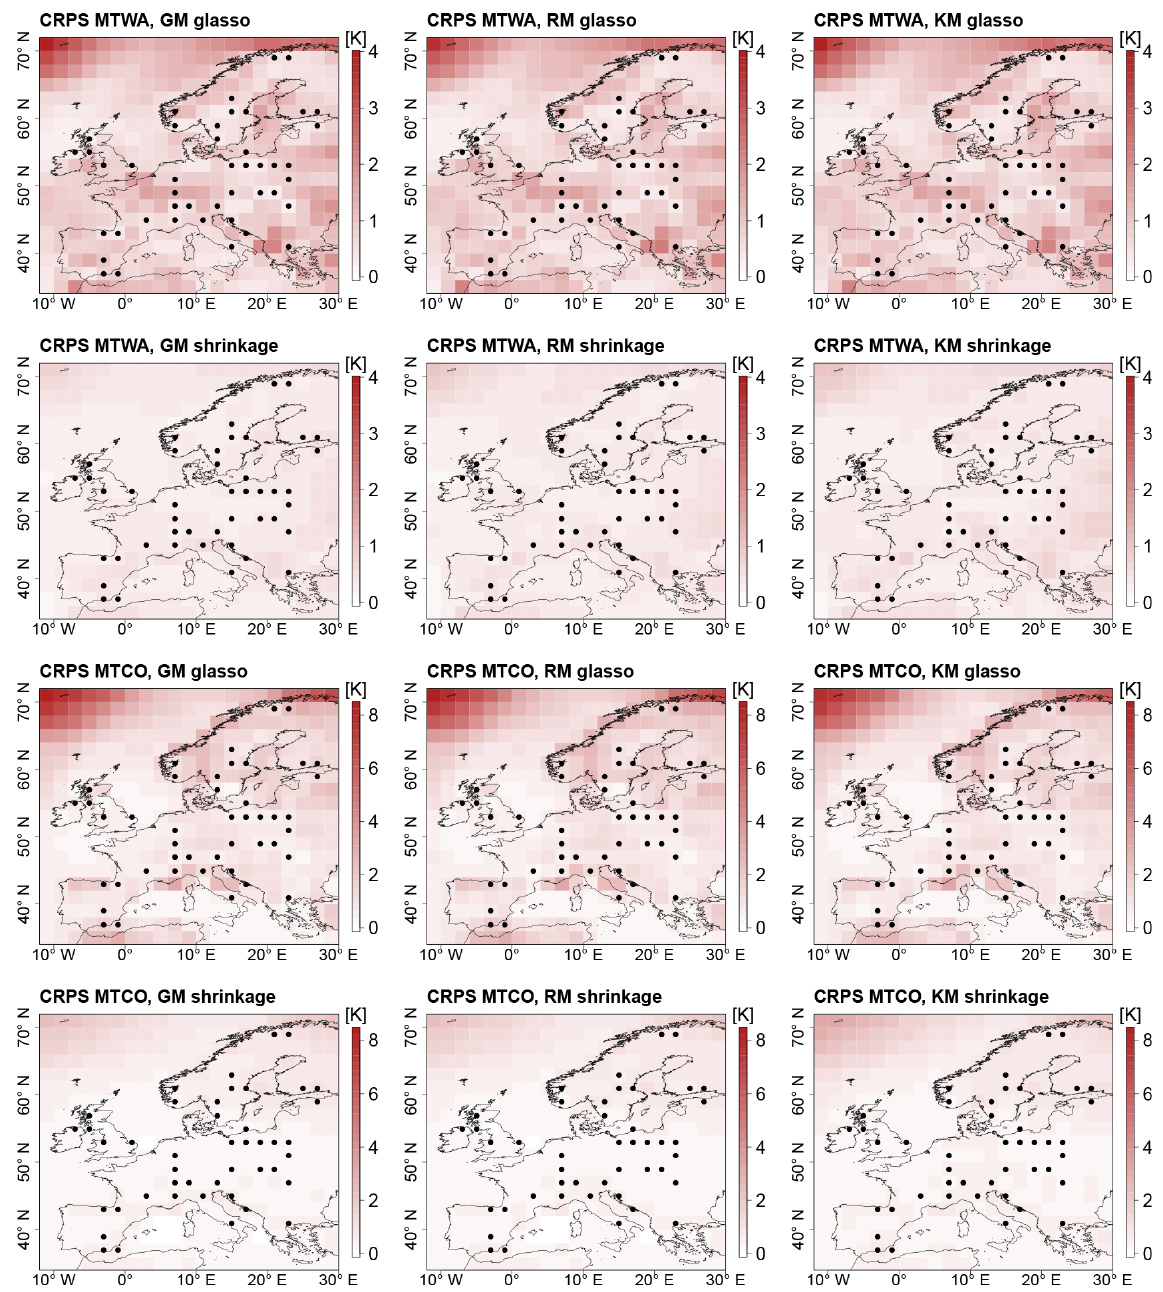
Figure 6. Mean CRPS in ITEs for GM, RM, and KM. Top row: models with glasso covariance matrix, MTWA. Second row: models with shrinkage covariance matrix, MTWA. Third row: models with glasso covariance matrix, MTCO. Bottom row: models with shrinkage covariance matrix, MTCO. Grid boxes with simulated proxy data are depicted by black